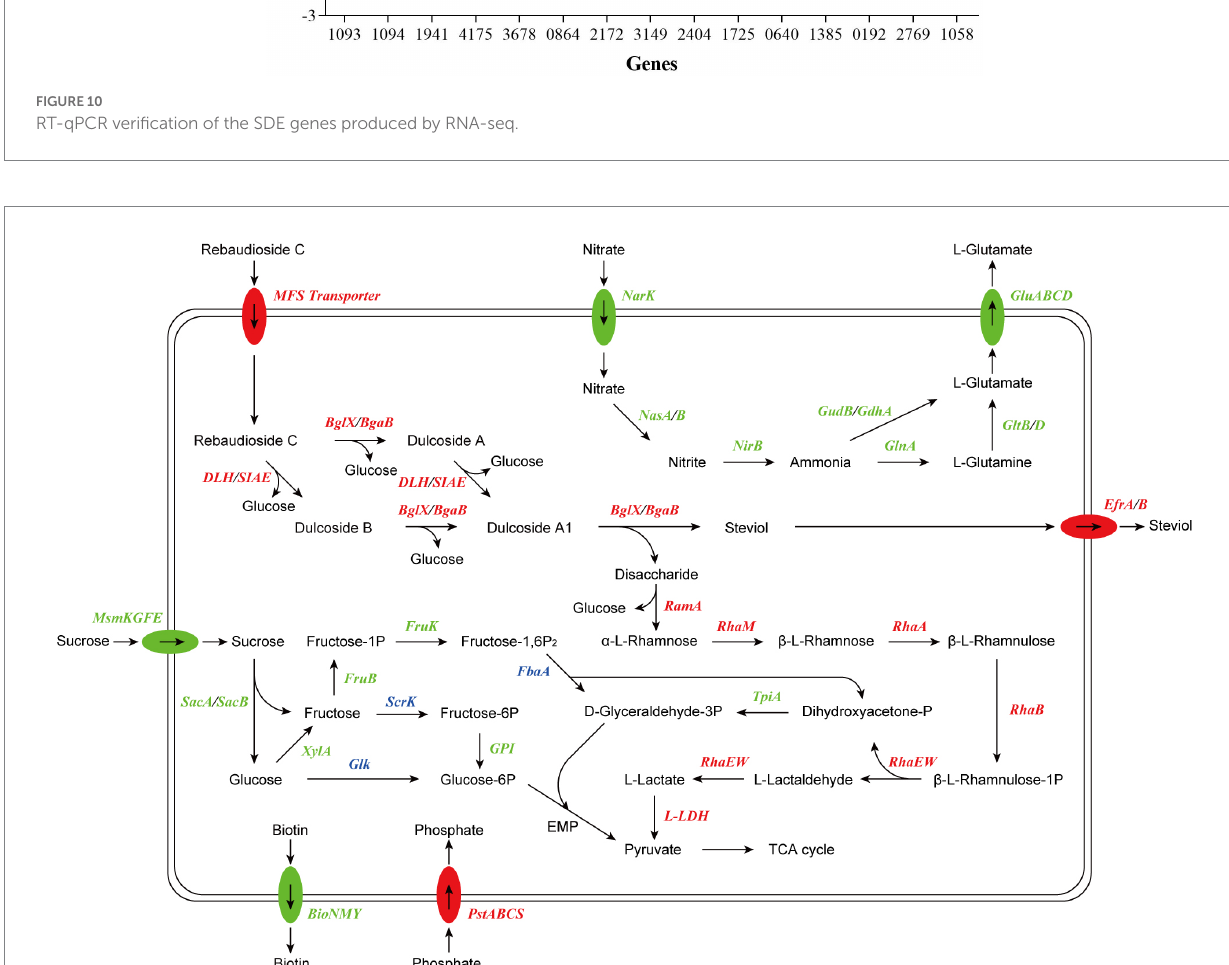
FIGURE 11 Proposed model of RC catabolism in CR5301. The abbreviations and corresponding encoding genes are listed in Supplementary Table S3. The enzymes marked in red are related to upregulated genes, the enzymes marked in green are related to downregulated genes, and the enzymes marked in blue are related to both upregulated and downregulated